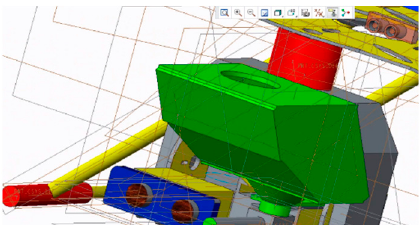
Figure 7. Gel ball blaster.